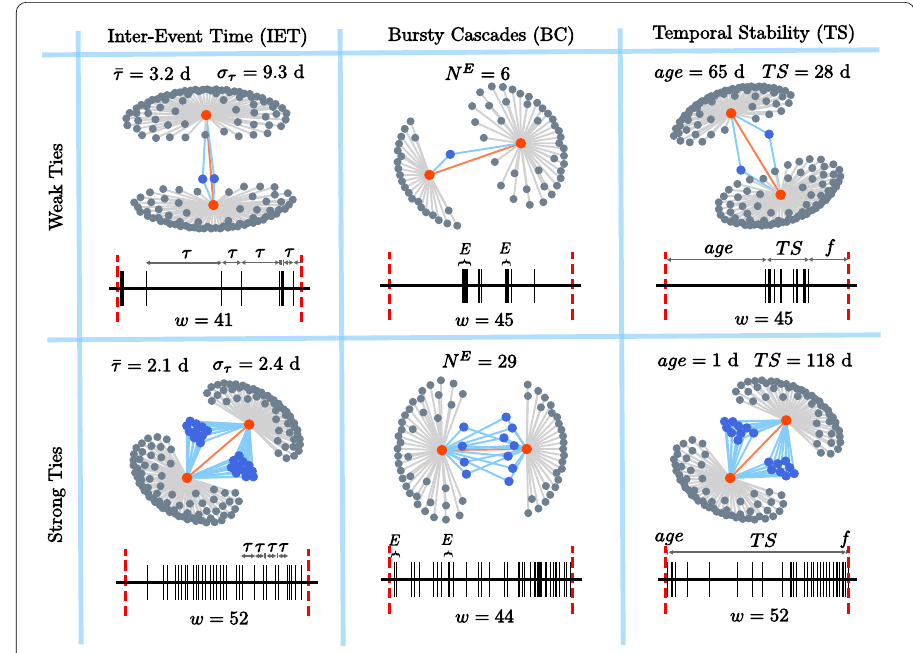
Figure 2 Differences in neighbourhood overlap ( top and bottom ) and selected temporal features of human communication (columns) for ties of similar communication intensity ( w ∈ [40,55)). Weak ( top ) and strong ( bottom ) ties are defined by low and high overlap, respectively, where we analyze communication patterns of red ties ( ij ), blue ties represent common neighbors ( N i ∩ N j ), and grey ties represent neighbors of either i or j but not both. ( Left ) IET distribution; we model the time between two consecutive calls as a homogeneous process via a random variable τ , and obtain statistics on the IET distribution, such as ¯ τ and σ τ , both measured in days. ( Center ) Bursty Cascades; given a parameter (cid:2) t , we identify event bursts E as sub-sequences of calls that are placed at most (cid:2) t seconds within each other. N E is the number of events. ( Right ) Temporal stability; we focus on the first and last events and their distribution within the observation period (red dashed lines), and determine the age as the time until the first call, the temporal stability TS as the time window where